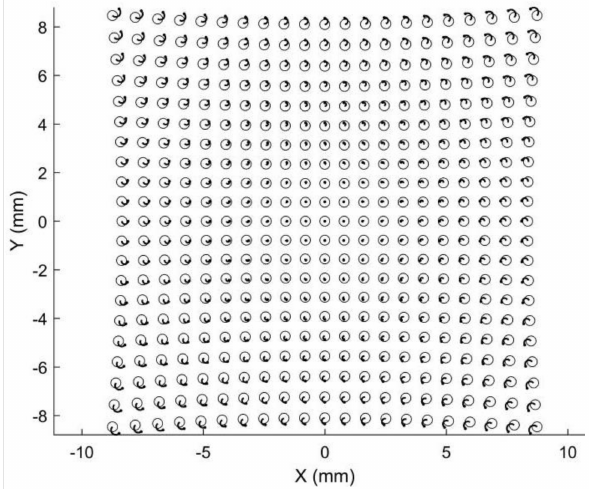
Figure 6. Simulated image points tracing from the vertical position to the horizontal